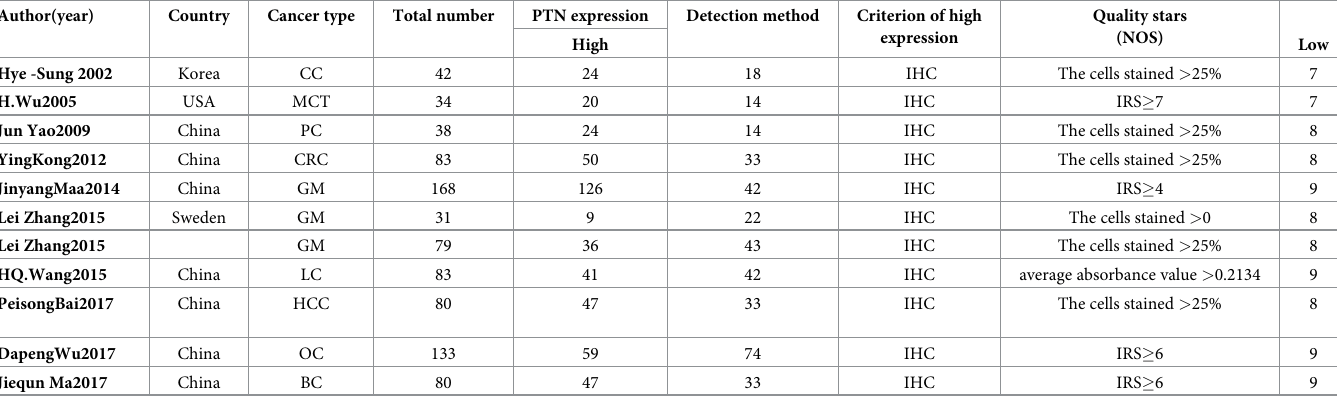
Table 1. The basic information and data of all included studies in the meta-analysis.